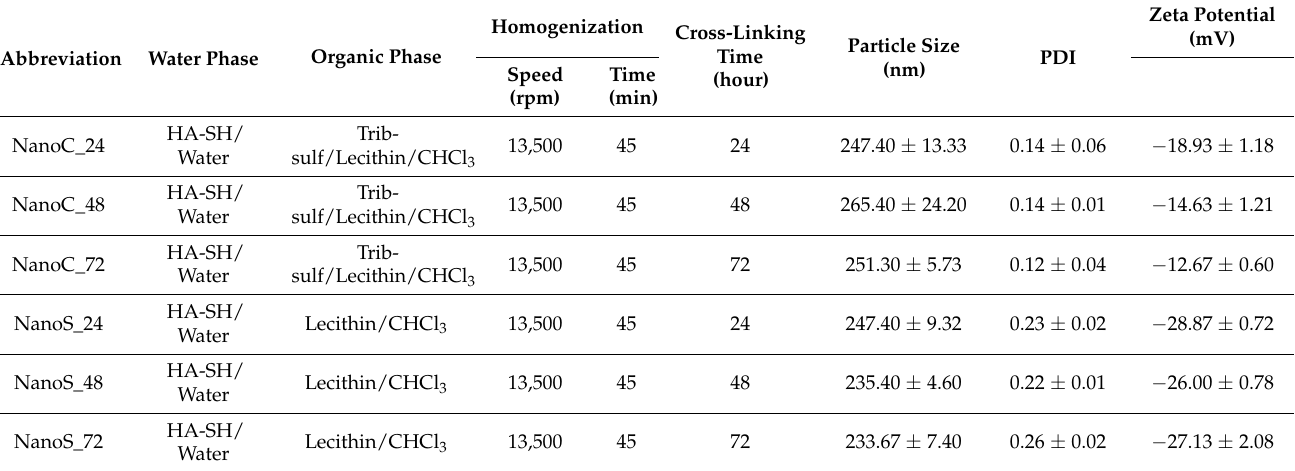
Table 3. Preparation condition, particle size, polydispersity index (PDI) and zeta potential of the NanoC and nanosphere (NanoS) characterized by dynamic light scattering